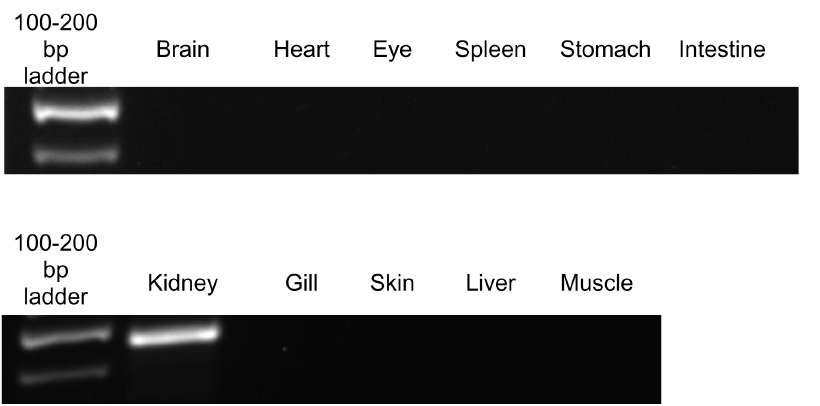
Figure 4. mRNA expression of gulonolactoneoxidase ( gulo ) from the brain, heart, eye, spleen, stomach, intestine, kidney, gills, skin, liver and muscle of Himanturasignifer kept in freshwater.